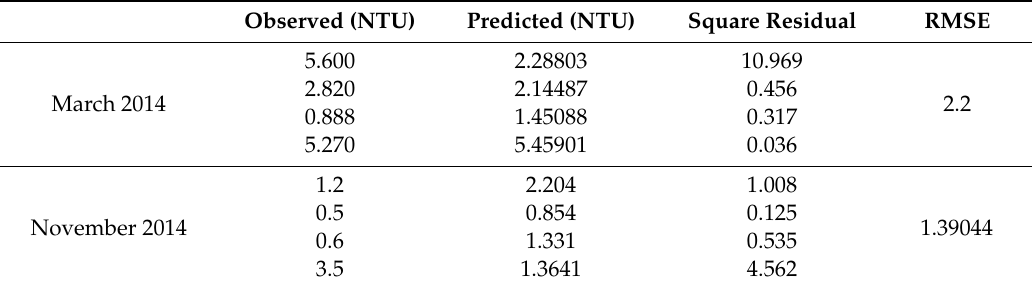
Table 6. Validation of the retrieved model in March and November 2014.